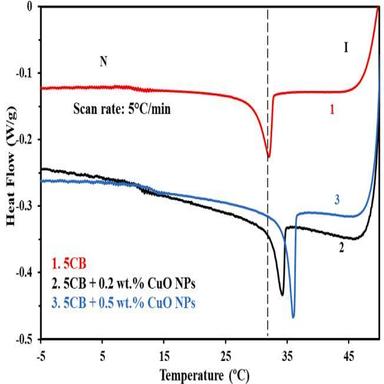
DSC thermograms for the cooling cycles for pure 5CB and its nanocomposites. Broken vertical line indicates isotropic to nematic phase transition of pure 5CB.